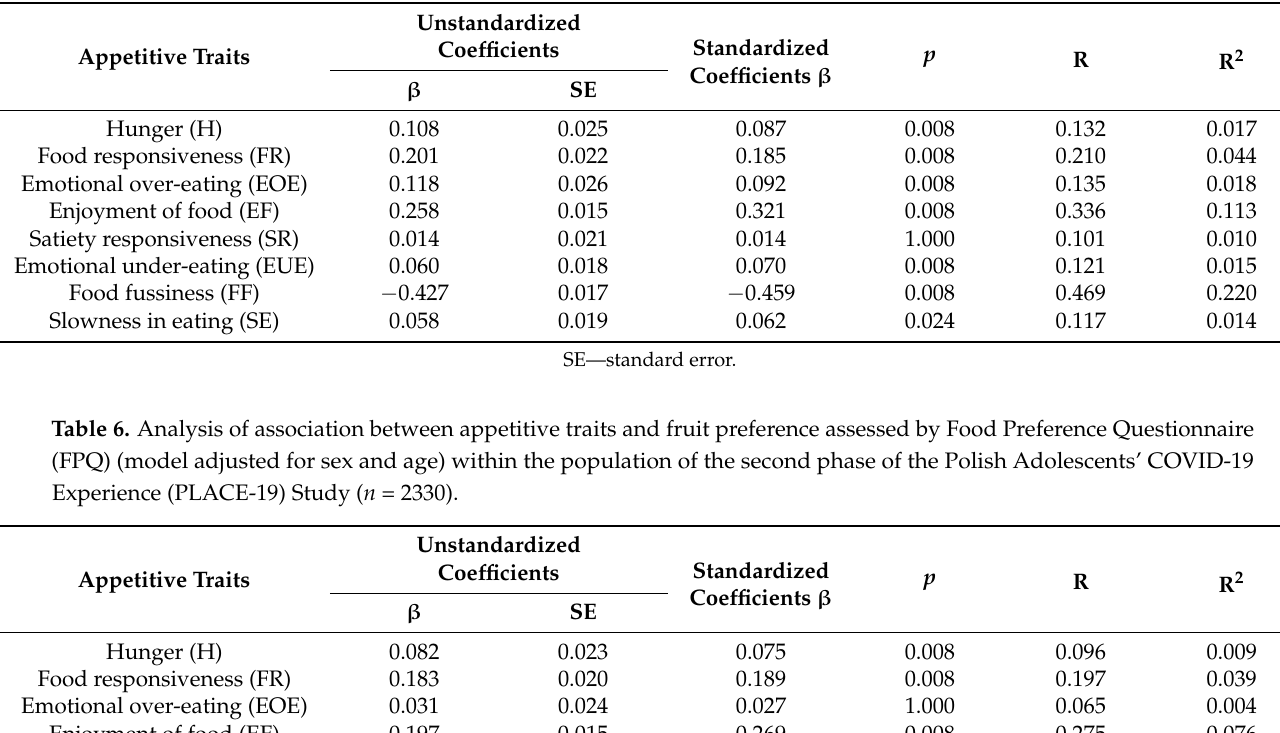
Table 5. Analysis of association between appetitive traits and vegetable preference assessed by Food Preference Ques- tionnaire (FPQ) (model adjusted for sex and age) within the population of the second phase of the Polish Adolescents’ COVID-19 Experience (PLACE-19) Study ( n = 2415).